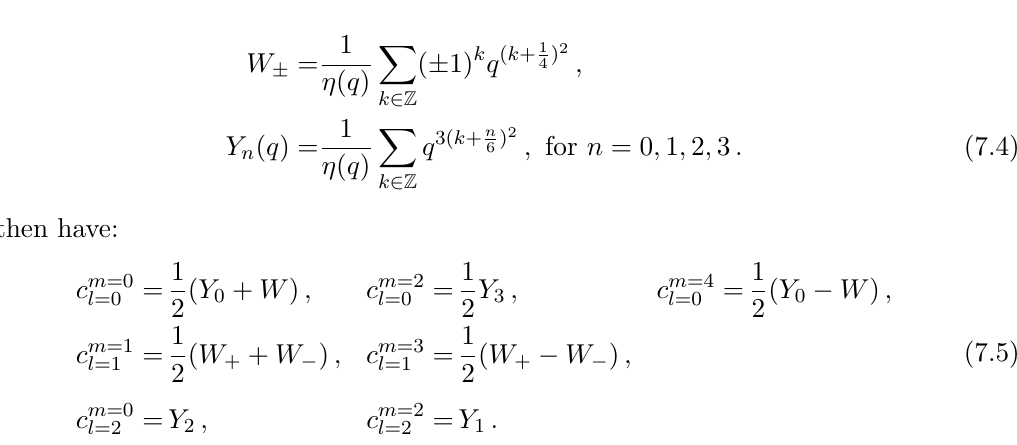
Figure 26 . The partition function of the three-state Potts model is equal to that of the six-vertex model, where the six vertices all have the same Boltzmann weight. Each of the circles can take one of three colours (represented by 1,2 and 3) in any given con(cid:12)guration, and no two nearest neighbours can have the same colour. Each con(cid:12)guration of the three-state Potts model is mapped to the six vertex model. An example of this mapping with alt boundary conditions on both the left and right boundary is shown in the image on the left. Alt boundary conditions can be seen to correspond to re(cid:13)ecting boundary conditions in the six-vertex model. An example of the mapping for alt boundary conditions on the left boundary and free boundary conditions on the right boundary is shown in the (cid:12)gure on the right. With free boundary conditions there is no constraint on arrows, as illustrated on the right boundary (in the (cid:12)gure on the